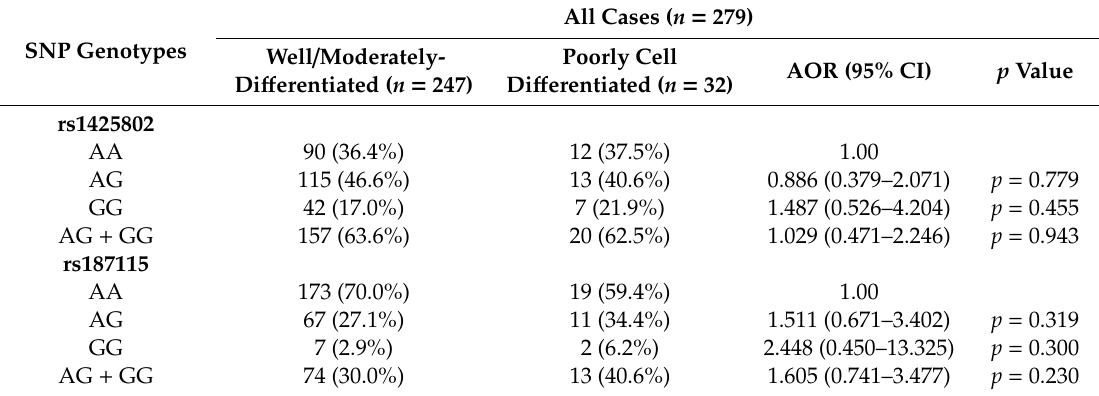
Table A3. The associations between the polymorphisms of CD44 and the cell di ff erentiation status in lung